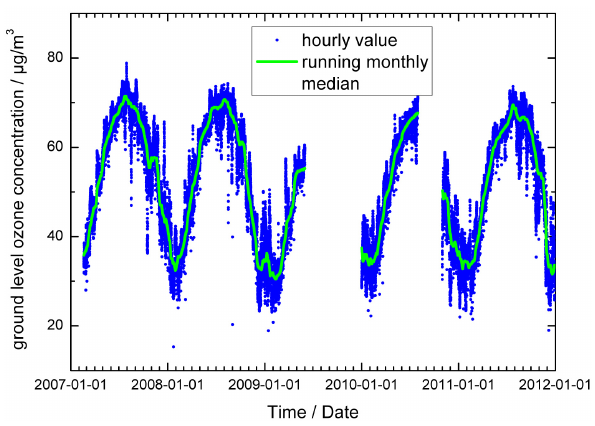
Fig. 7. This graph uses the baseline air mass criterion based on the aerosol scattering coefficient to divide the Troll ozone data into two sub-data sets: (1) baseline air mass cases (left panel); (2) non-baseline air mass cases (right panel). For each hourly averaged data point in the two sub-data sets, the difference to the 4-week running 25th, 50th, and 75th percentiles was calculated. The plot contains the averages of these differences for the two data subsets. This is done to investigate whether the baseline cases have a systematically higher ozone concentration than the non-baseline cases, while at the same time removing the annual cycle in the ozone data caused by photochemical destruction. Events of local contamination have been filtered out before the 20